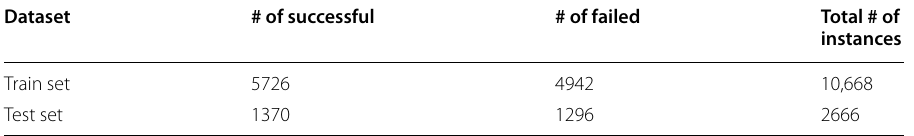
Table 5 Training vs . test split and respective class distributions (5-fold cross-validation was employed in the experiments. This table shows split of one fold)